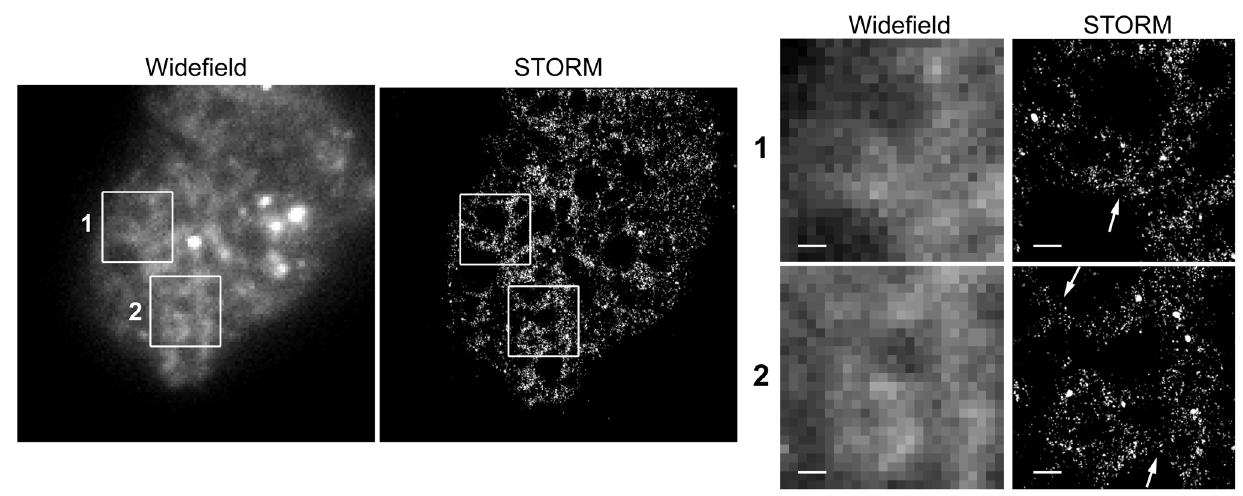
Figure 4. STORM imaging of an E.histolytica trophozoite. Super resolution microscopy of the amebic endoplasmic reticulum (ER) using a SNAP-tag protein with a KDEL ER retention signal. Inlayed boxes and arrows show the three way bifurcations that are characteristic of the ER, and the improved resolution that the STORM method provided (scale bar is 500 nm).